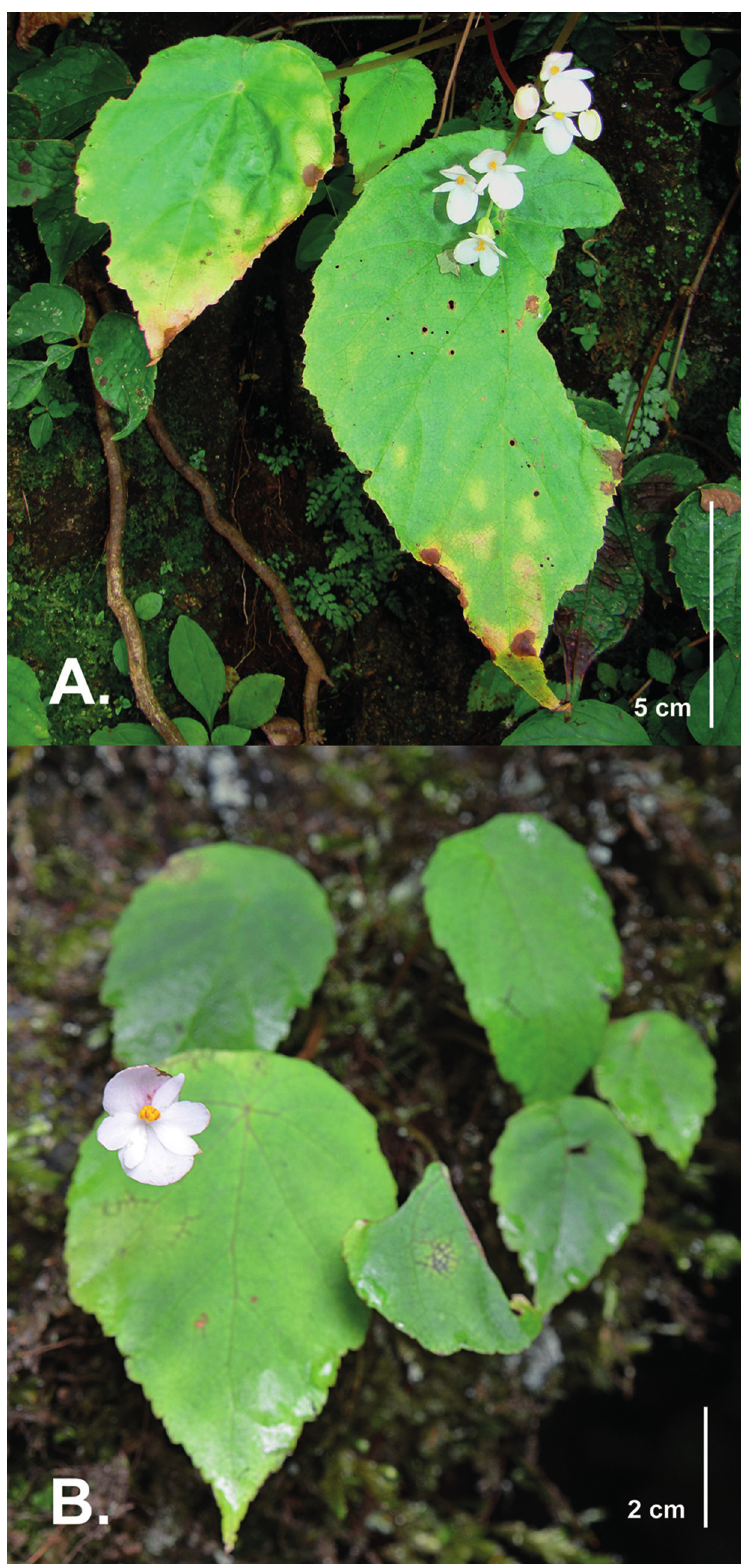
Fig. 32. Begonia josephi A.DC. A . Plant habit. B . Male flower. Photographs courtesy of Sangeeta Rajbhandary of plants in